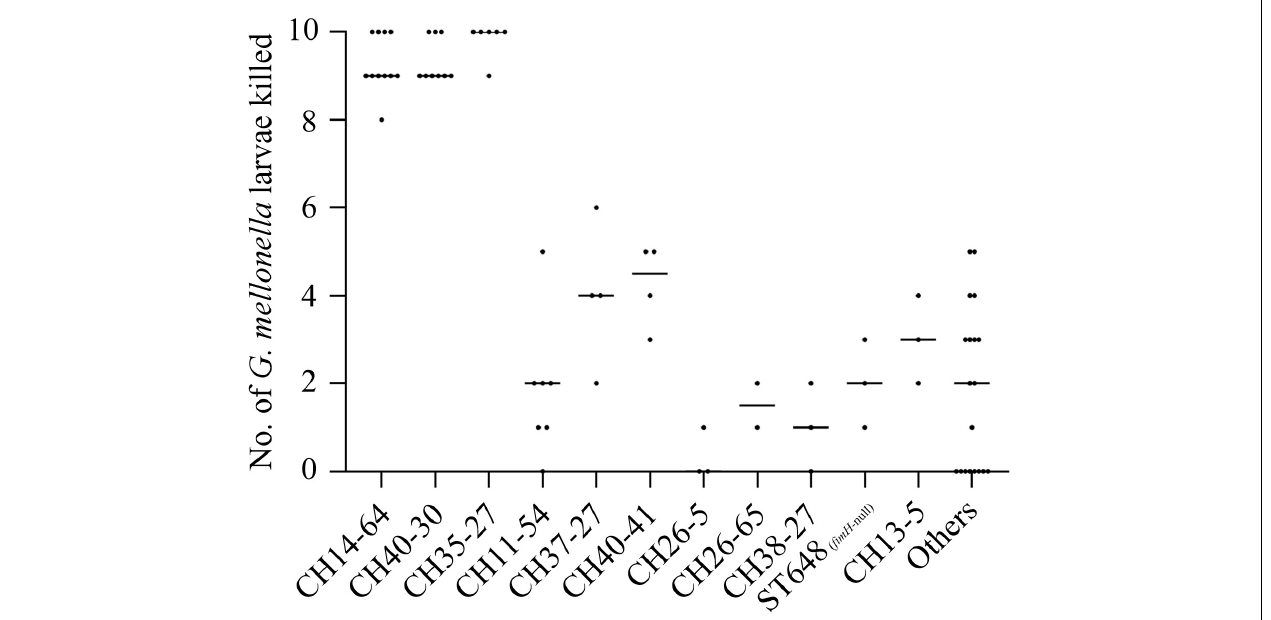
FIGURE 1 | The number of larvae killed in a G. mellonella infection model according to CH or ST types among the 74 ExPEC isolates. Lethality in larvae (10 larvae/ E. coli strain) was observed for 4 days after infection with test strains. Each dot corresponds to one test strain, its corresponding abscissa represents the average number of three independent experiments for the strain, and its corresponding ordinate represents the CH or ST types of the strain. Non-infected larvae and PBS challenged larvae showed no mortality. Low larvae mortality ( ≤ 20%) was recorded following challenge with E. coli DH5 α . The Mann–Whitney U test showed the number of larvae killed in CH14-64, CH40-30, and CH35-27 groups were not statistically different, but higher than that in any of the remaining groups ( P <